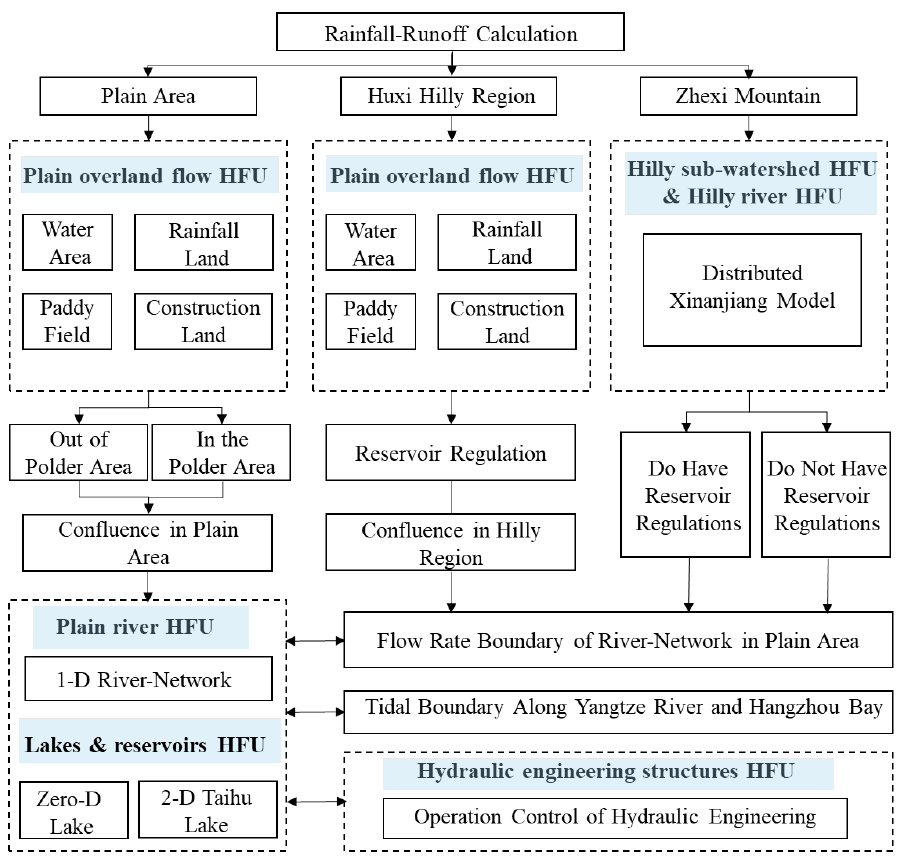
Figure 3. The logical architecture diagram of the distributed-frame hydrological model in Taihu Basin.